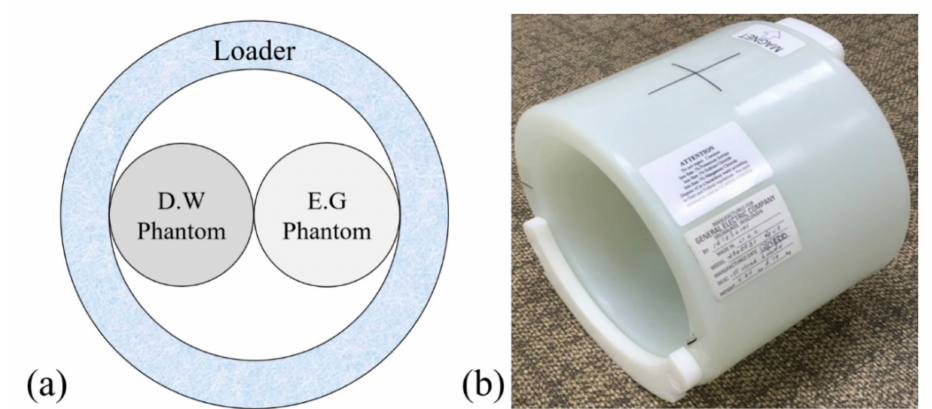
Figure 2. ( a ) Configuration of the distilled water and ethylene glycol phantoms and ( b ) conventional head loader. Distilled water and ethylene glycol phantoms were placed side by side at the center of inside the conventional head